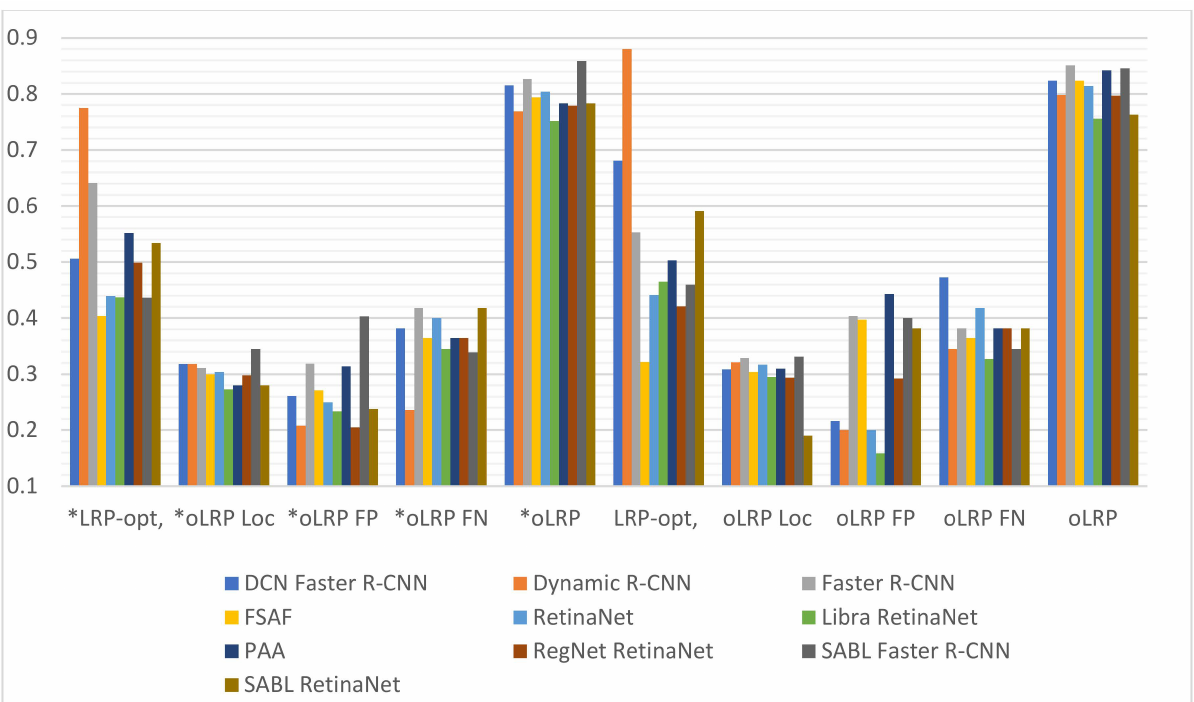
Figure 14. Validation LRP-optimal threshold (LRP t ), oLRP Loc (oLRP L ), oLRP FP and oLRP FN results of detection models. (* with